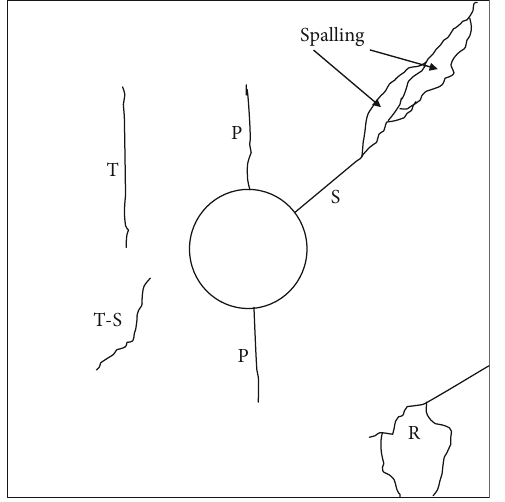
Figure 6: Types of cracks around circular holes (T: tensile crack, S: shear crack, T-S: tensile-shear crack R: remote crack, and P: primary